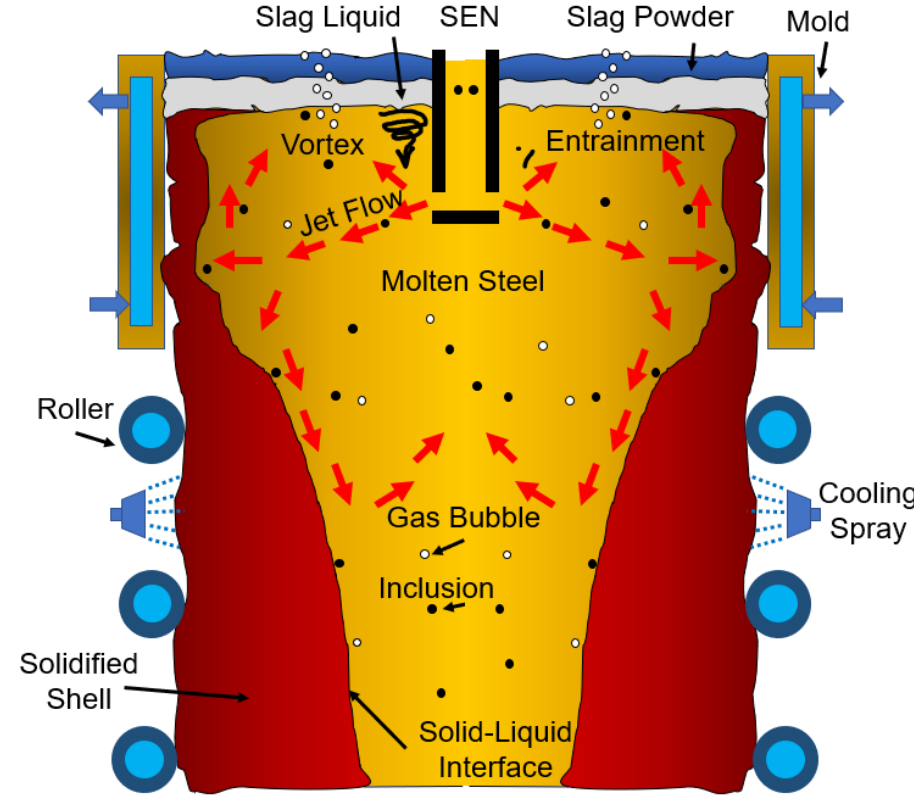
Figure 1. Schematic diagram of the continuous casting mold.